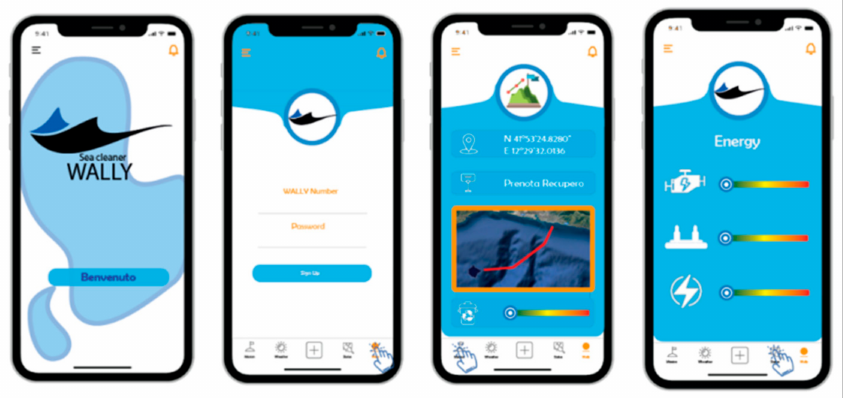
Figure 15. Drone tracking